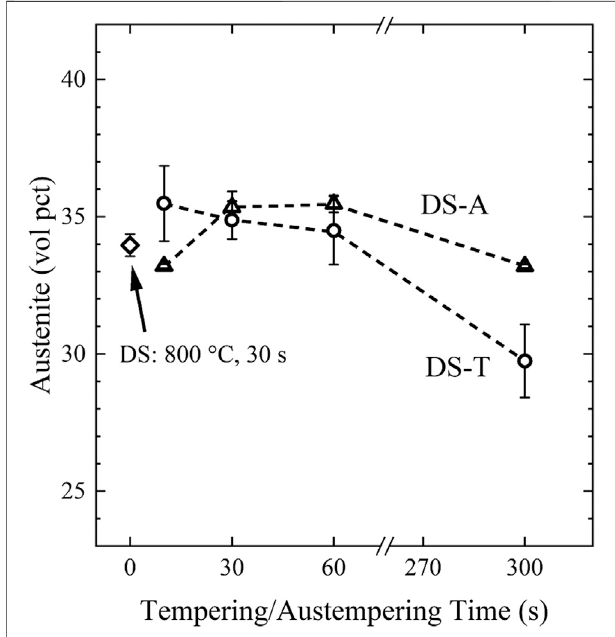
FIGURE 6 | Retained austenite volume fraction as a function of tempering or austempering time for the DS-T and DS-A heat treatments (Jatczak, 1980). The retained austenite fraction for the initial condition, DS: 800 ° C, 30 s, is also indicated. Error bars represent the standard error of three measurements in each heat treatment